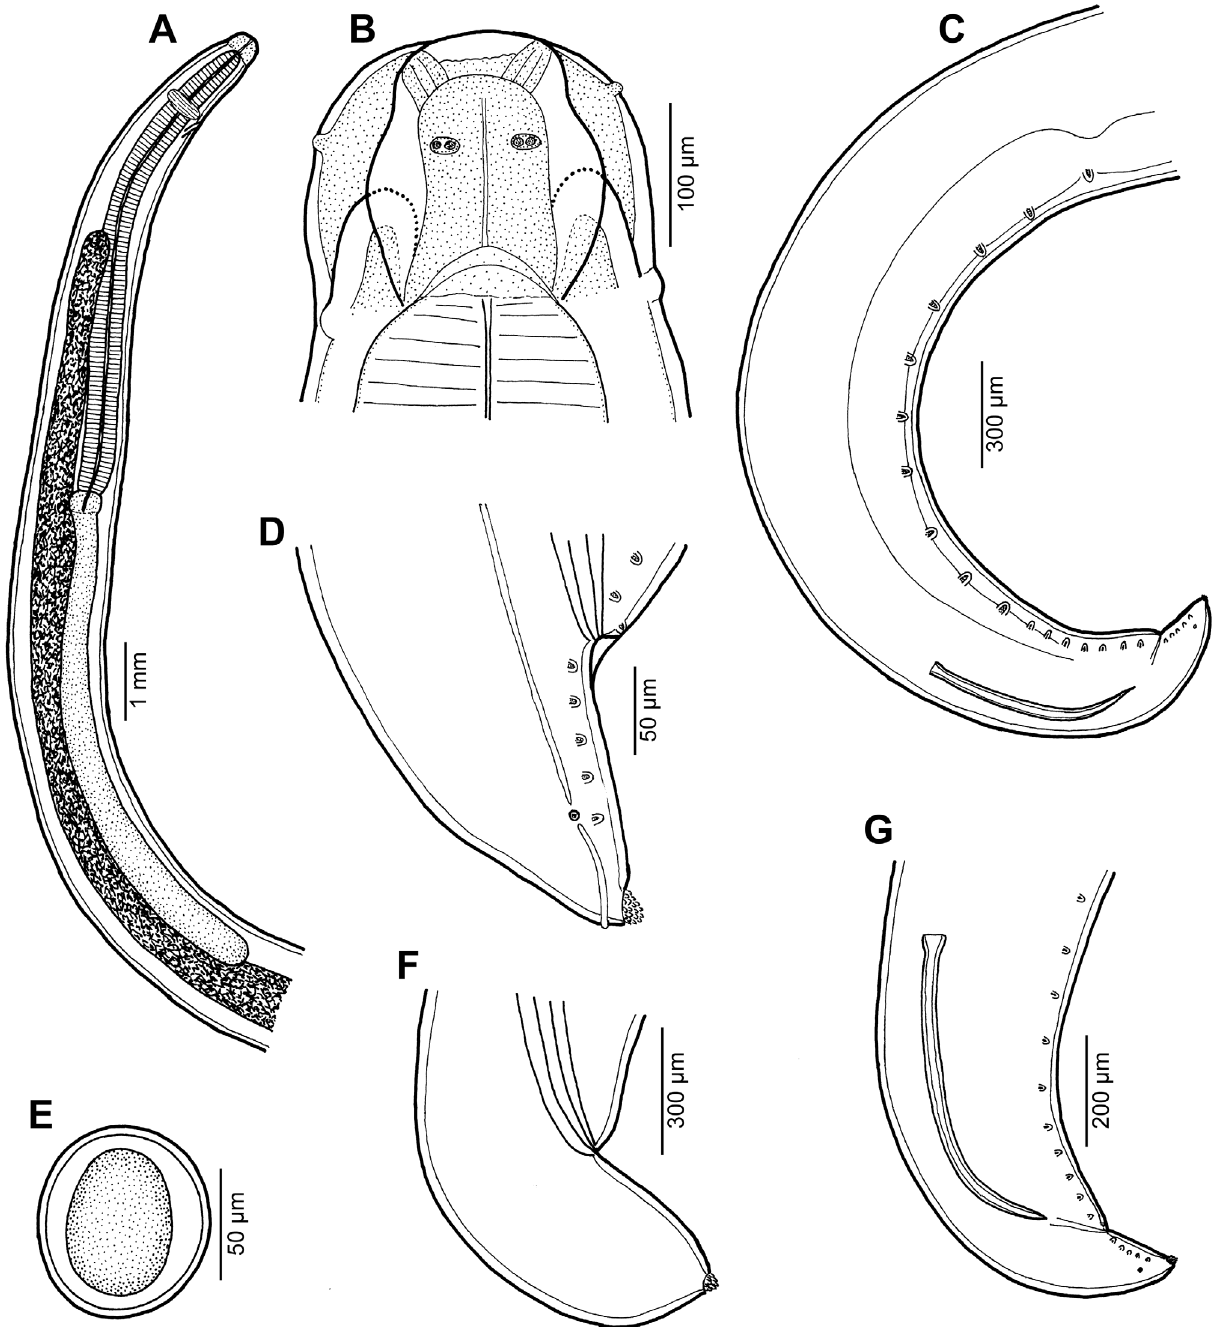
Figure 15. Hysterothylacium epinepheli (Yamaguti, 1941) ex Epinephelus maculatus . (A) Anterior end of male, lateral view; (B) cephalic end of male, dorsal view; (C) posterior end of male, lateral view; (D) tail of male, lateral view; (E) egg; (F) tail of gravid female, lateral view; (G) caudal end of male, lateral